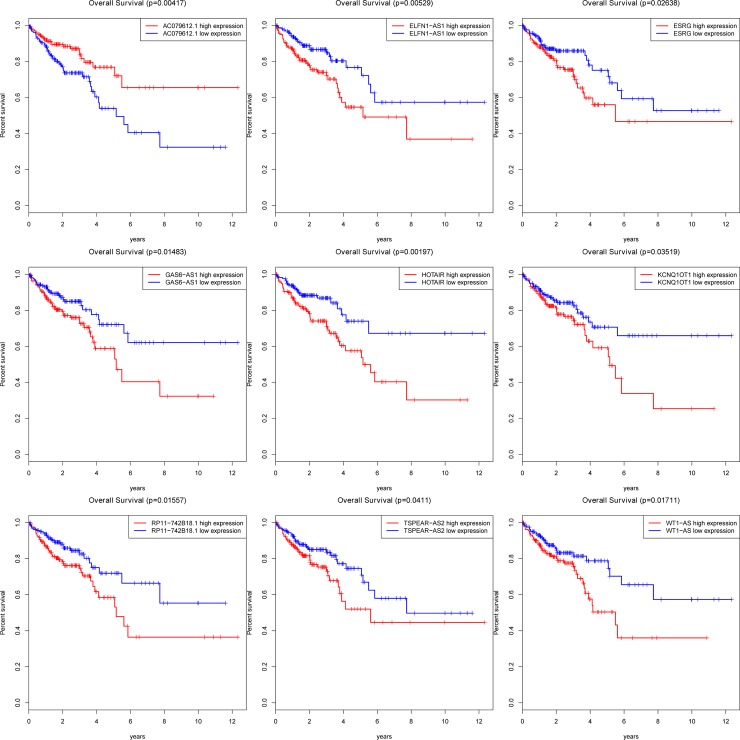
Nine lncRNAs associated with overall survival in colon cancer base on Kaplan-Meier survival curves.The horizontal axis represents overall survival time (years), vertical axis represents survival function. (9DElncRNAs were presented (P < 0.05), including KCNQ1OT1, WT1-AS, HOTAIR, GAS6-AS1, AC079612.1, ELFN1-AS1, RP11-742B18.1, TSPEAR-AS2 and ESRG).